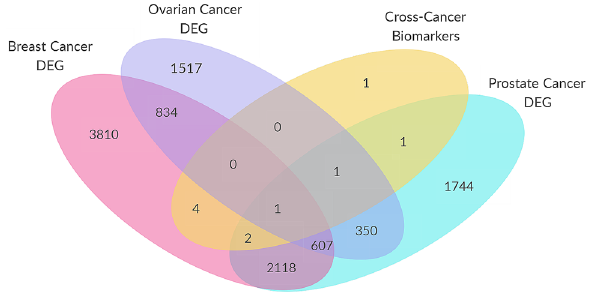
Figure 6. Venn diagram showing the relationship of the Top-10 cross-cancer biomarkers (Top CC ALL) and DE genes from the three cancers. All but one of the Top-10 cross-cancer (Top CC ALL) biomarkers are found to be differentially expressed.